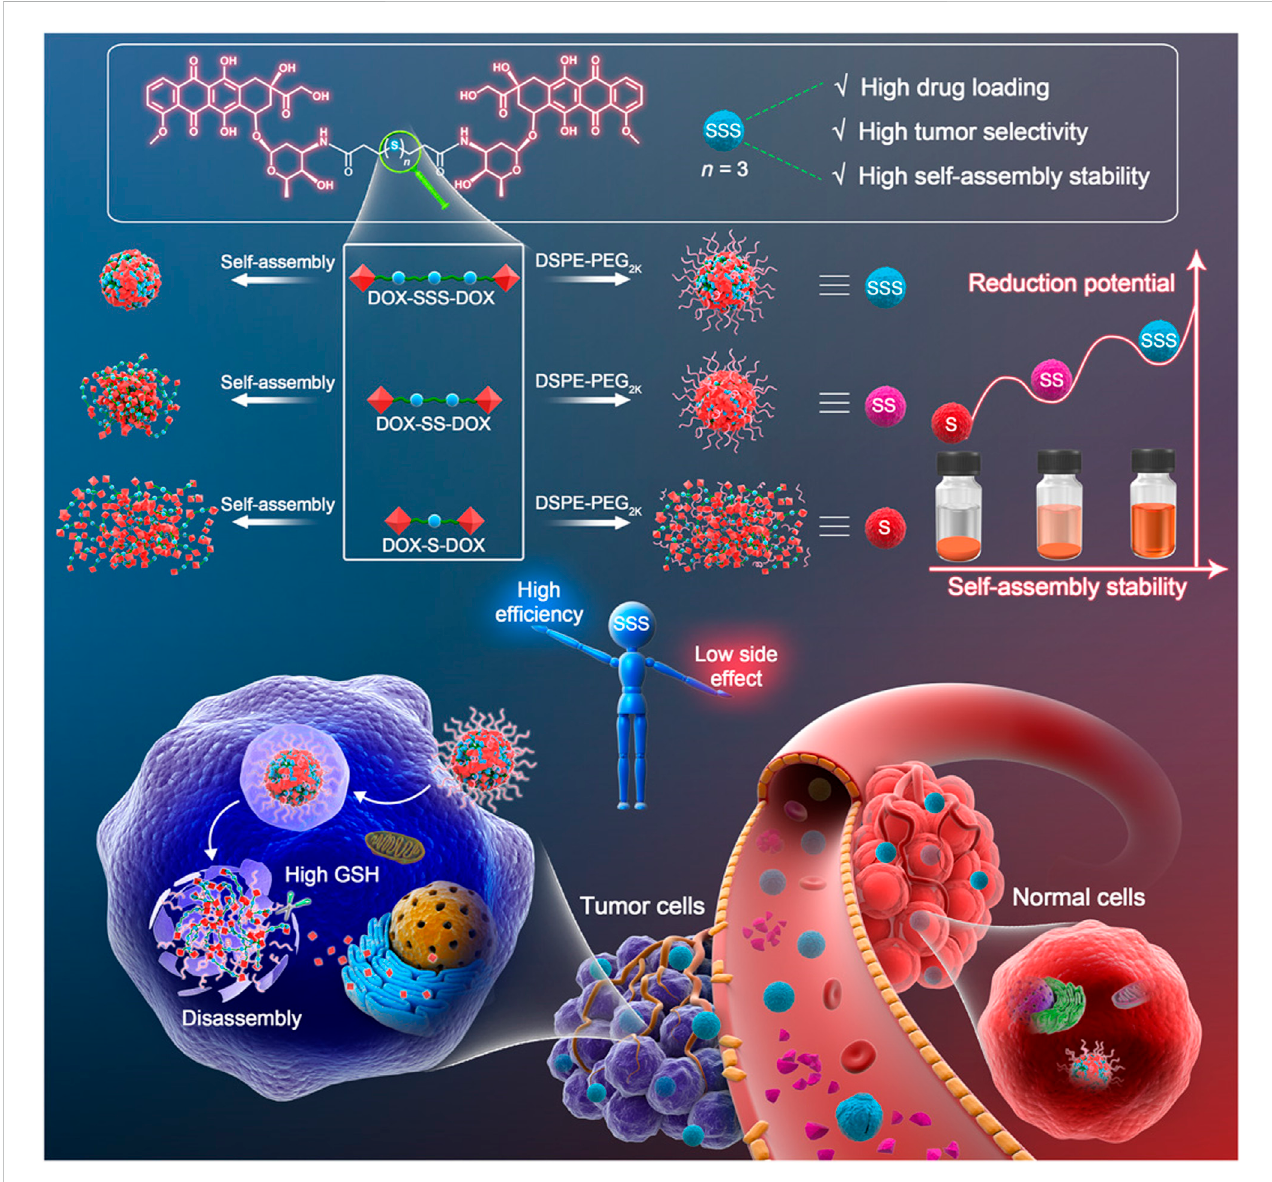
FIGURE 7 Thetrisul fi debond – bridgedprodrugnanoassembliesforcancertherapy.Simpleinsertionofatrisul fi debond – transformedDOXhomodimericprodrugs into self-assembled nanomedicines with three highlights: high drug loading, high self-assembly stability, and high tumor selectivity. Reproduced with permission from (Yang et al., 2020b) Copyright (2020) American Association for the Advancement of Science.